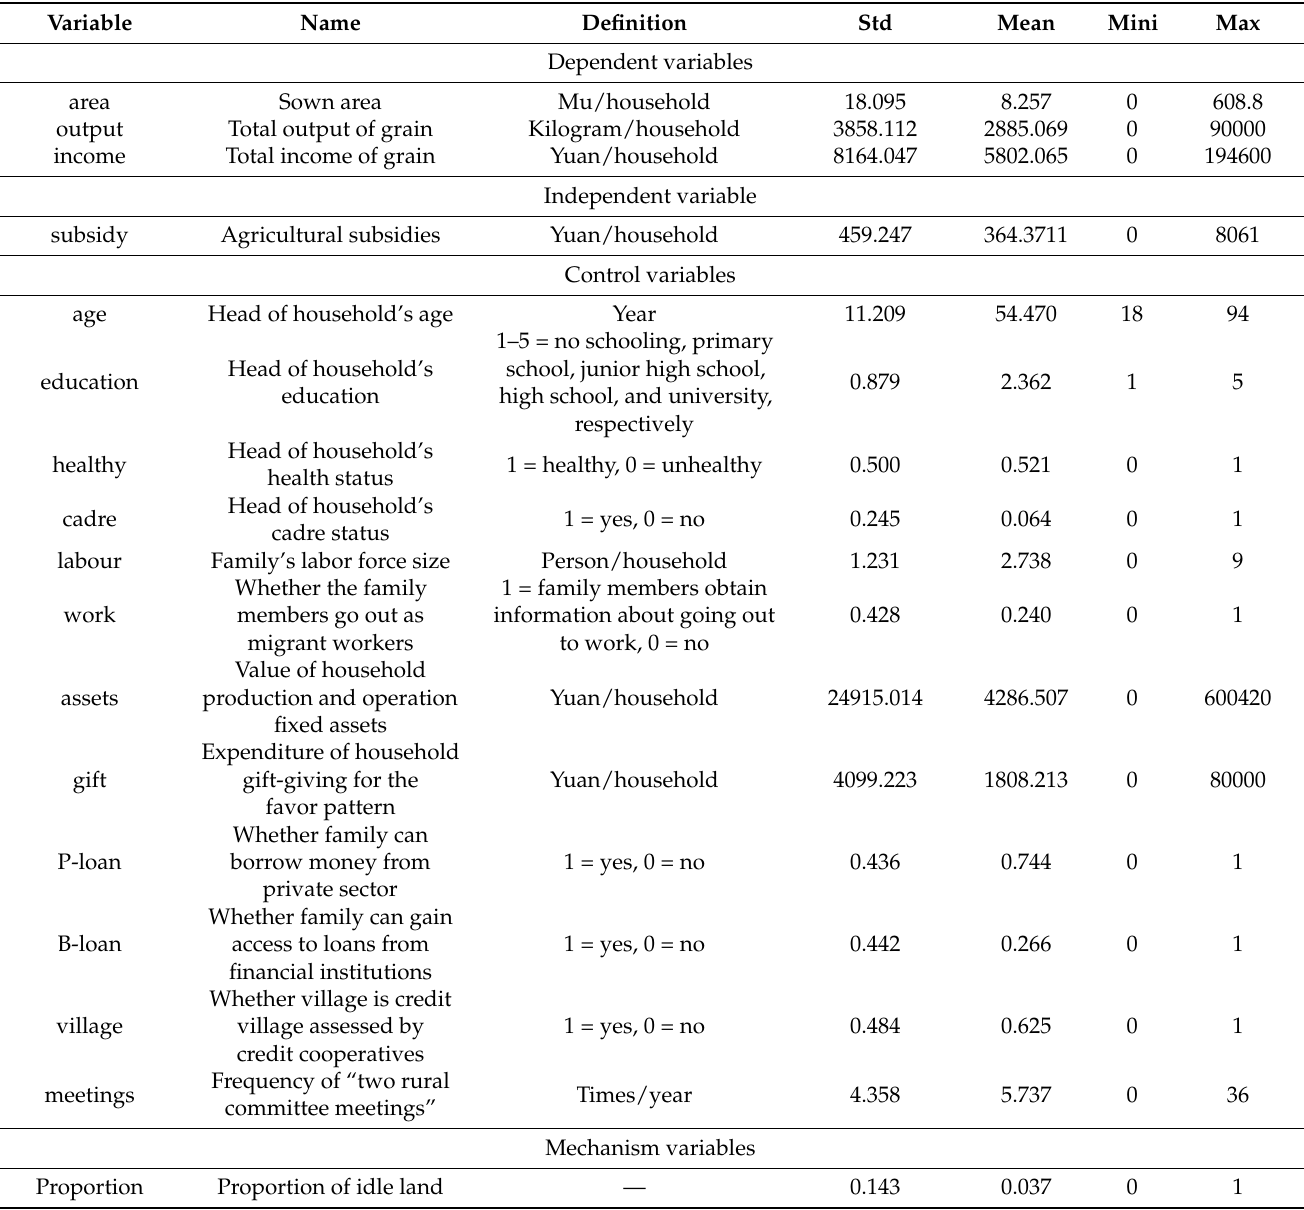
Table 1. Main variables and their descriptive statistics. ( n =